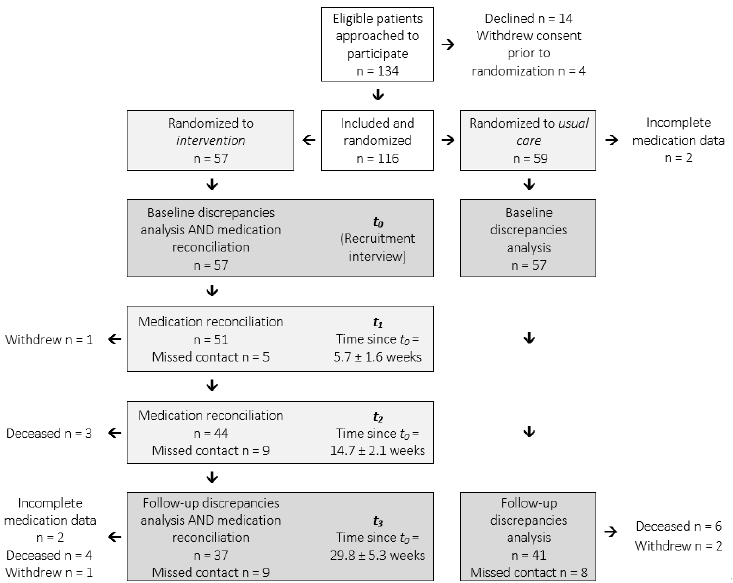
Figure 1. Flow diagram of patient recruitment and follow up timelines. At recruitment, participants who reported self-managing their medications were taking a smaller median number of medications (7.0 [interquartile range (IQR) 6.0–10.0] vs. 11.0 [IQR 9.0–13.0], p < 0.001). A greater proportion of patients with hepatic encephalopathy (HE) reported receiving assistance with medications (i.e., a pharmacy packing aide or assistance from a family member/caregiver) than those without HE (57.5% vs.